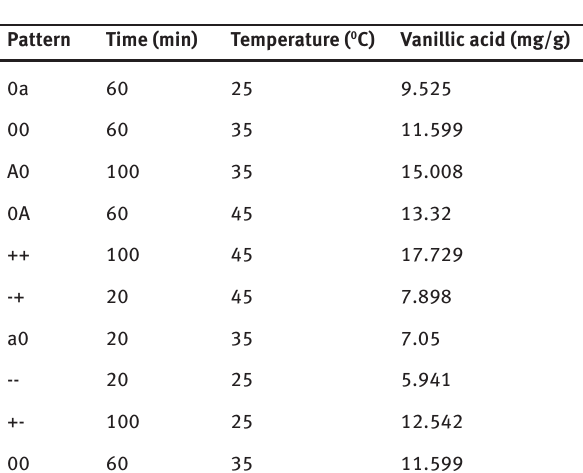
Table 1 : Response surface design for the optimization of the extraction